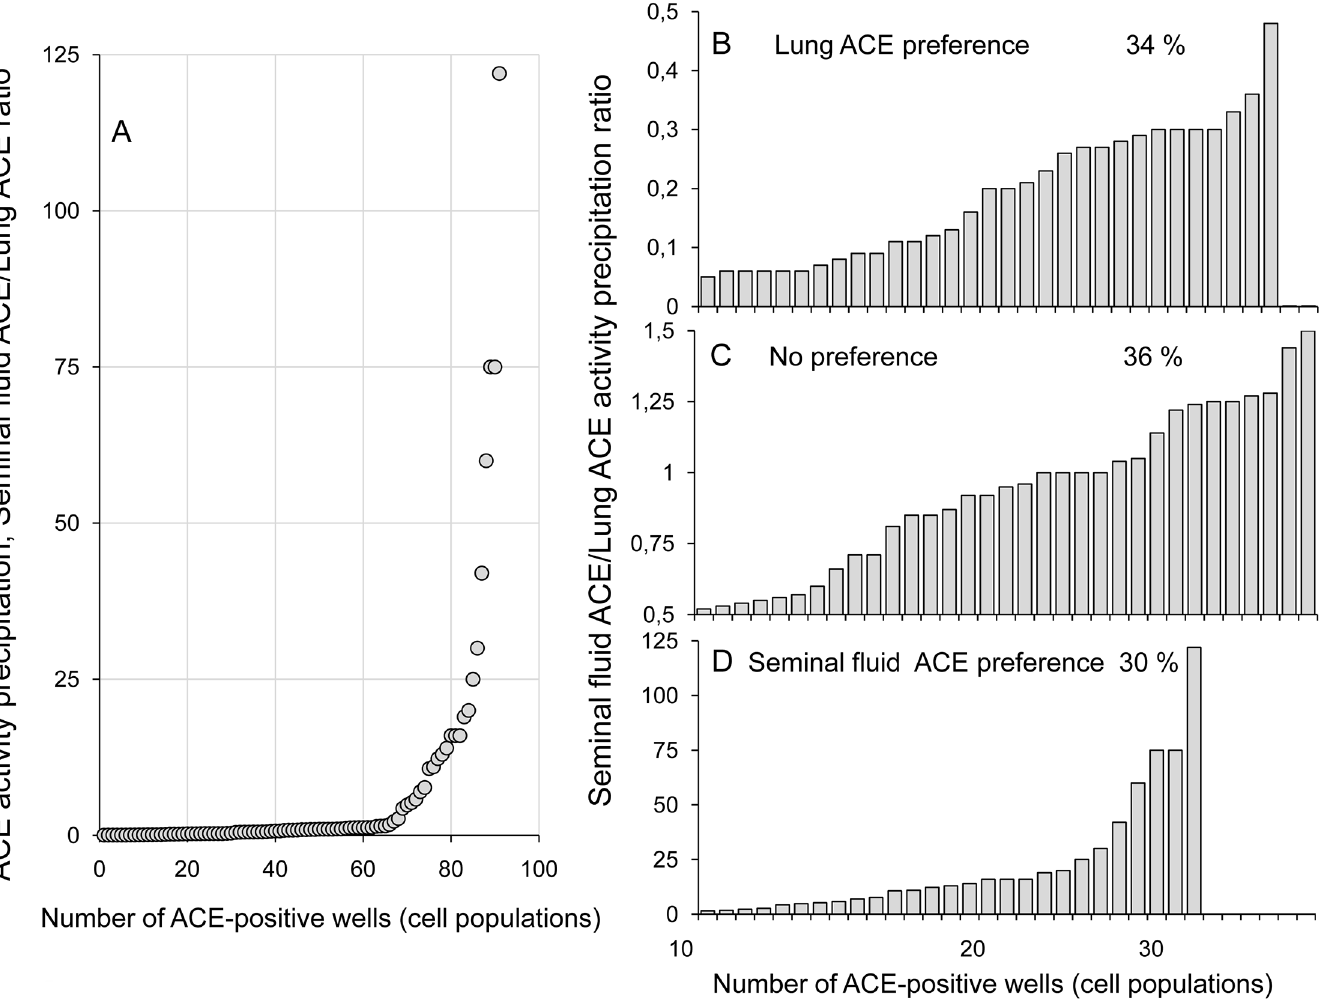
Fig 7. Primary immune response in mice to pure somatic ACE from seminal fluid. Culture fluids from 670 post-fusion cell populations grown in 96-well plates (primary screening) were anylyzed for the presence of antibodies to seminal fluid ACE and lung ACE in parallel in plate precipitation assay (as in Fig 1). Presence of antibodies to seminal fluid and/or lung ACE was detected in 91 wells by precipitated ACE activity and the data are presented as the ratio of ACE activity precipitation from seminal fluid ACE to that from lung ACE (SF/Lung ratio). Discrimination of these two ACEs by antibodies from these positive wells was observed in a wide range (A). Besides expected antibodies, recognizing both ACEs (C) with SF/Lung ratio in the region from 0.5 to 1.5, we identified significant proportions of antibodies which preferentially recognized seminal fluid ACE (B) with SF/Lung ratio more than 1.5, and antibodies which preferentially recognized lung ACE (D) with SF/Lung ratio less than 0.5,